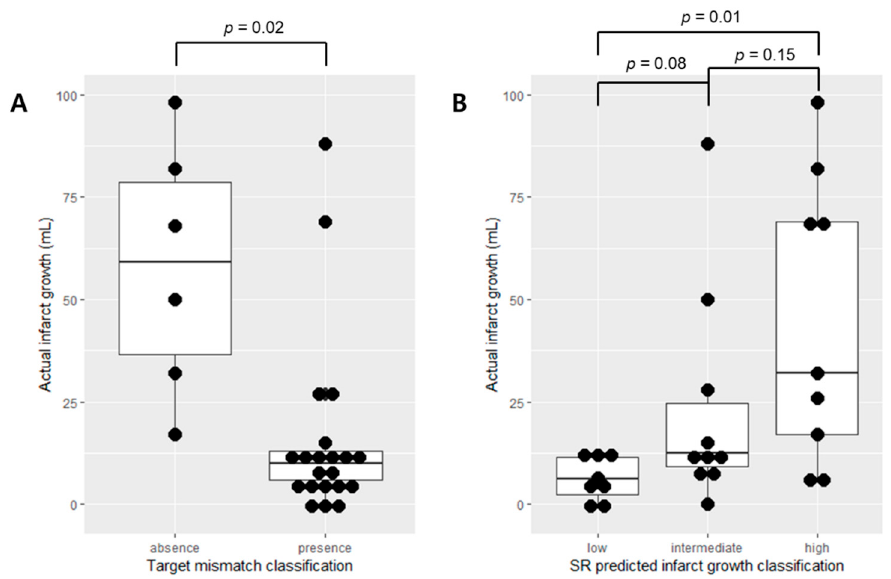
Figure 4. Infarct growth distribution in the external validation SR patients ( n = 27). ( A ) Target mismatch classification. ( B ) SR-predicted infarct growth classification. In ( A ), the mismatch absence group shows a heterogeneous distribution of actual infarct growth. In ( B ), the high group (SR-predicted infarct growth ≥ 35 mL) shows a heterogeneous distribution of actual infarct growth, and the low group (SR-predicted infarct growth < 15 mL) shows the narrowest distribution of the actual infarct growth. The percentage values of favorable clinical outcomes of the day-90 mRS score ≤ 1 for the mismatch presence and absence groups in overall SR patients were 50% and 36%, respectively (Figure 5A). The percentage values of favorable clinical outcomes were 61%, 56%, and 25%, respectively, for the low, intermediate, and high SR-predicted infarct growth groups (Figure 5A). In UR patients, the percentage values of favorable outcomes for the mismatch presence and absence groups were 14% and 0%, respectively, while they were 9%, 18%, and 7%, respectively, for the low, intermediate, and high UR-predicted infarct growth groups (Figure